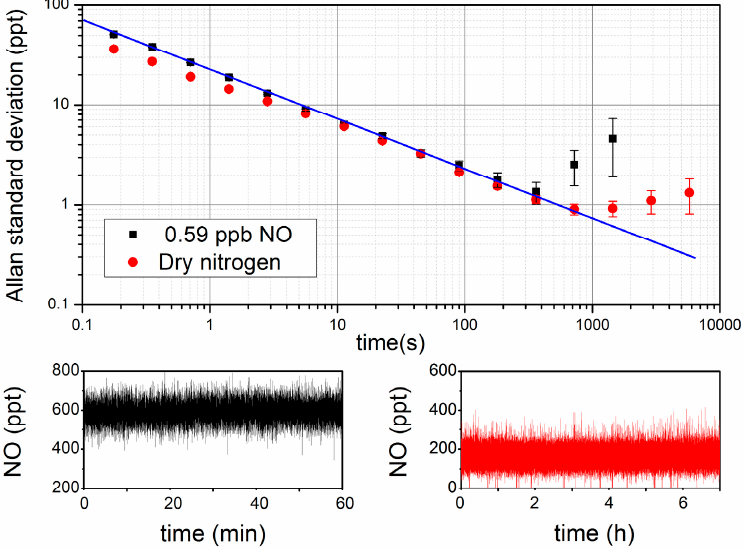
Figure 3. Top: Allan standard deviation derived from measurements shown at the bottom. In red, dry nitrogen (with residual traces of NO). In black, sample of 0.59 ppb of NO. The blue line represents the 1/√(cid:1872) slope expected from white noise averaging.